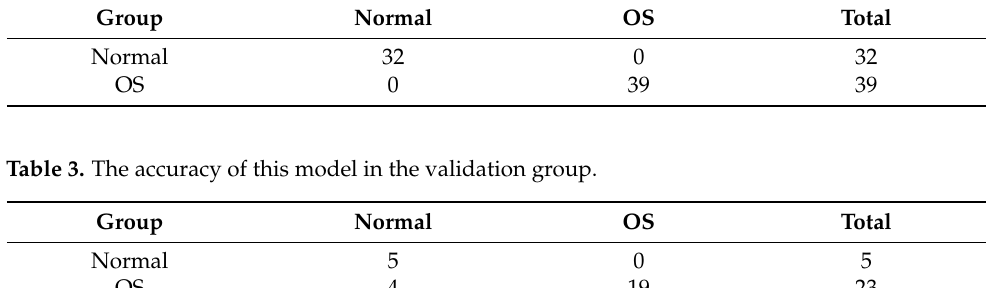
Table 2. The accuracy of the model in the training group.